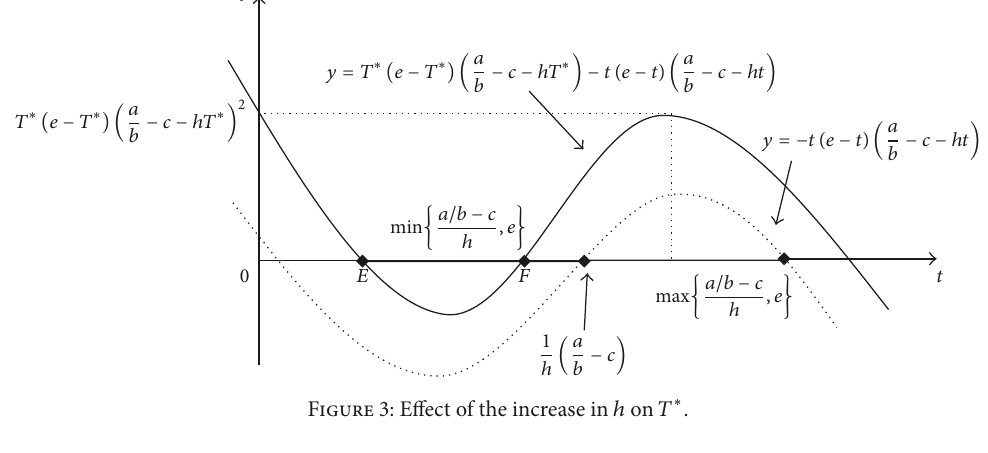
Figure 3: Effect of the increase in ℎ on 𝑇 ∗ .